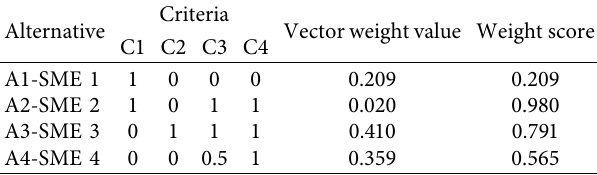
Table 9: Defuzzification ( d ′ ) ordinal value.